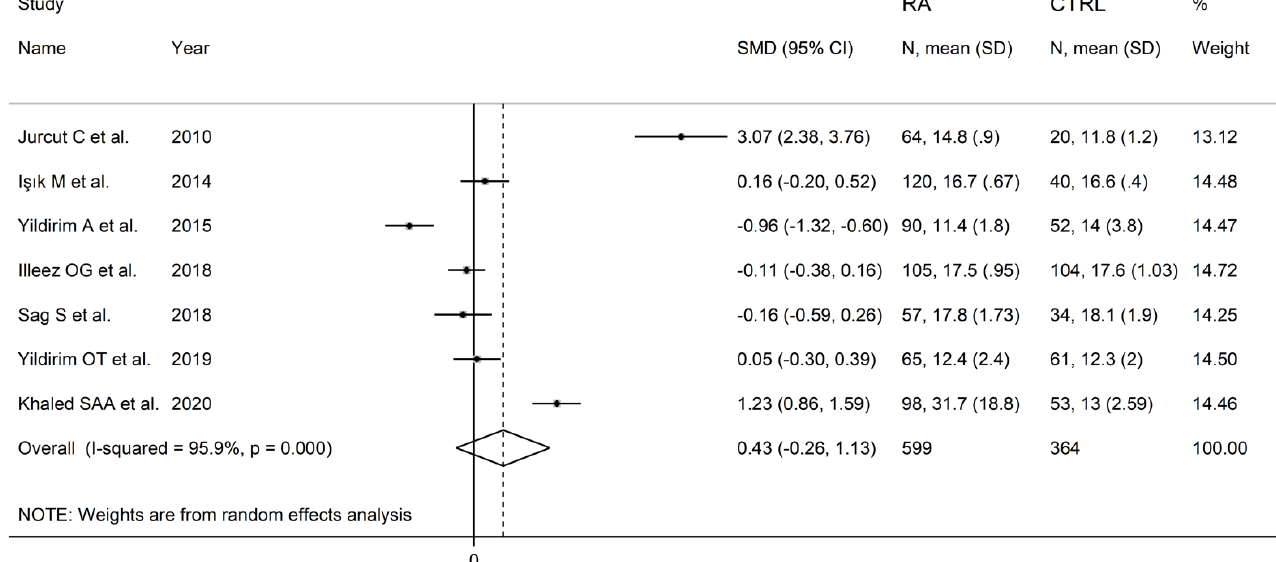
Figure 9. Sensitivity analysis of the association between the platelet distribution width and rheuma- toid arthritis. For each study, the displayed effect size (hollow circles) corresponds to an overall effect size computed from a meta-analysis excluding that study.